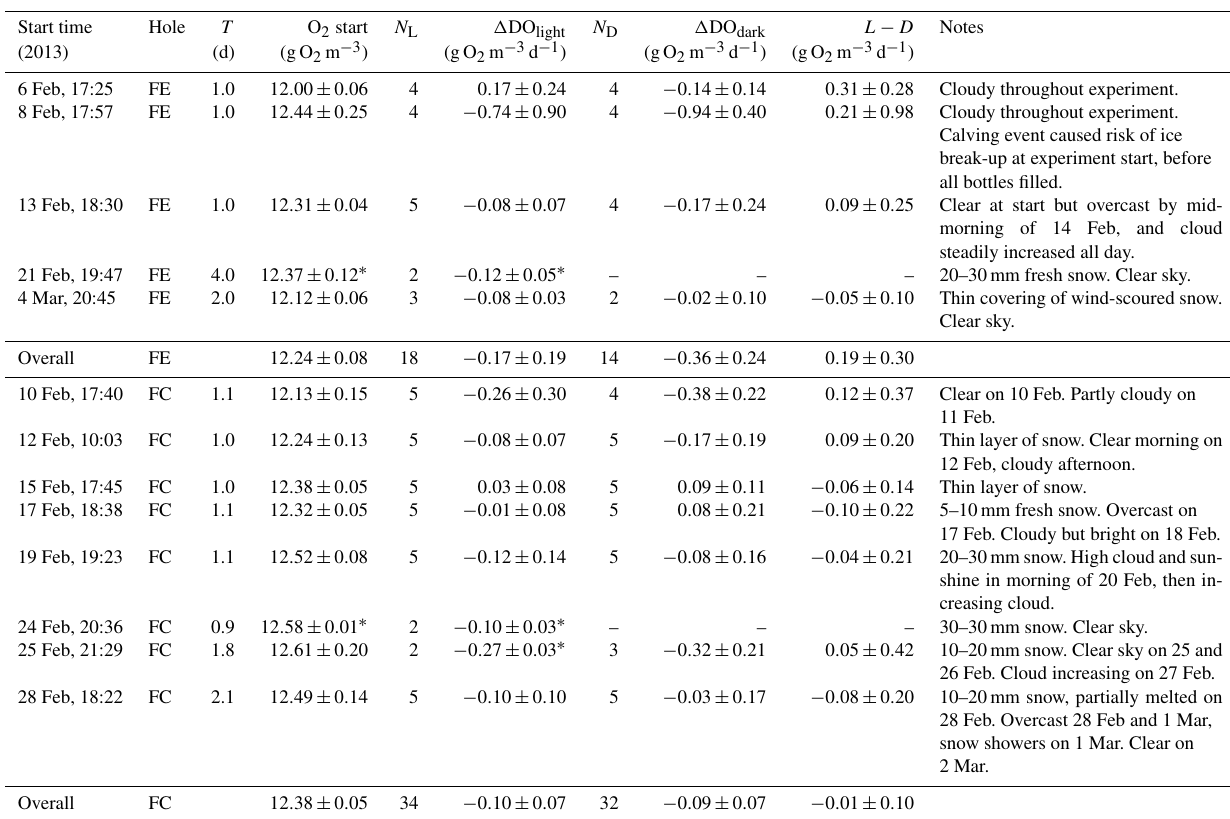
Table 2. Summary of results obtained in the incubation experiments at the two holes FE (fjord edge) and FC (fjord centre). Quoted values are means with 95% confidence intervals, except when N = 2 (as indicated by ∗ ), where the error bounds are simply the range of the two observations. T is the duration of the incubation, N is the number of samples, and L − D is the difference between the change in dissolved oxygen in the light bottles, and in the dark bottles ( (cid:49) DO light − (cid:49) DO dark